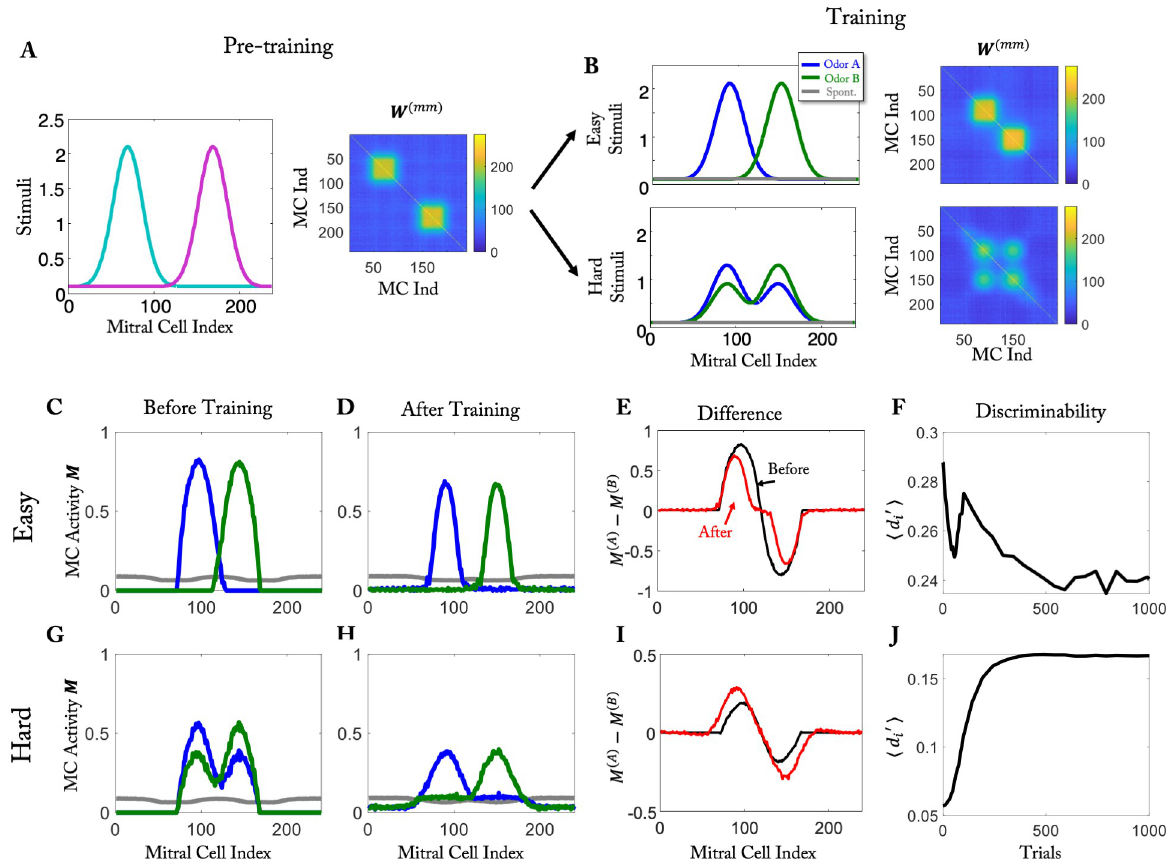
Fig 3. Visualization of the differential learning outcome for easy and hard tasks. (A) Stimuli for pre-training and effective connectivity matrix after pre-training. (B) Training stimuli for the easy task (top) and the hard task (bottom) and the resulting connectivity matrix after training. (C to F) Easy task: (C) MC Activity before training (after pre-training). (D) MC activity after training. (E) Activity difference before (black) and after training (red). (F) Temporal evolution of the discriminability during training. (G to J) As (C to F) but for hard